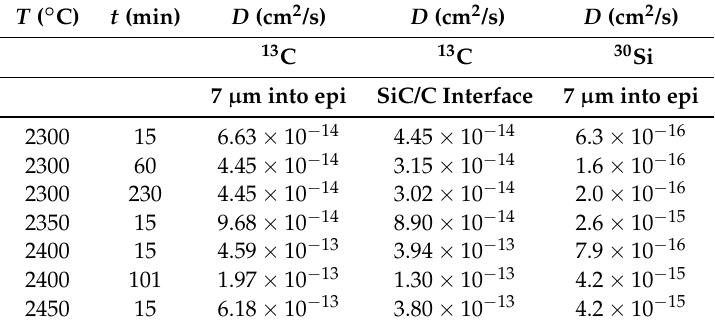
Table 2. Estimated diffusivities for 13 C and 30 Si migration in 4H-SiC samples under intrinsic conditions and at various temperatures. 13 C profiles are collected both at the interface 7 µ m into the epi-layer, and at the C/4H-SiC surface, while 30 Si diffusivities are from the internal 4H-SiC interface only. T ( ◦ C)